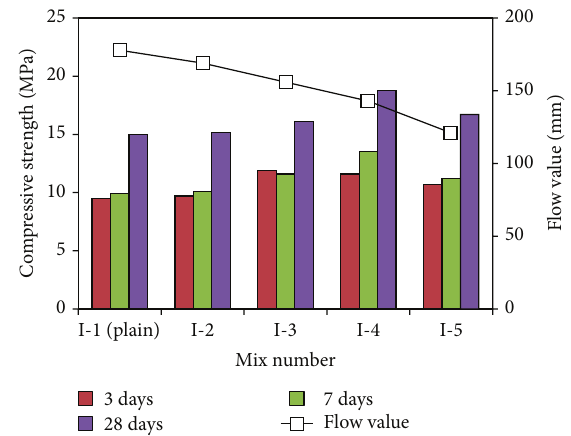
Figure 3: Setting time.